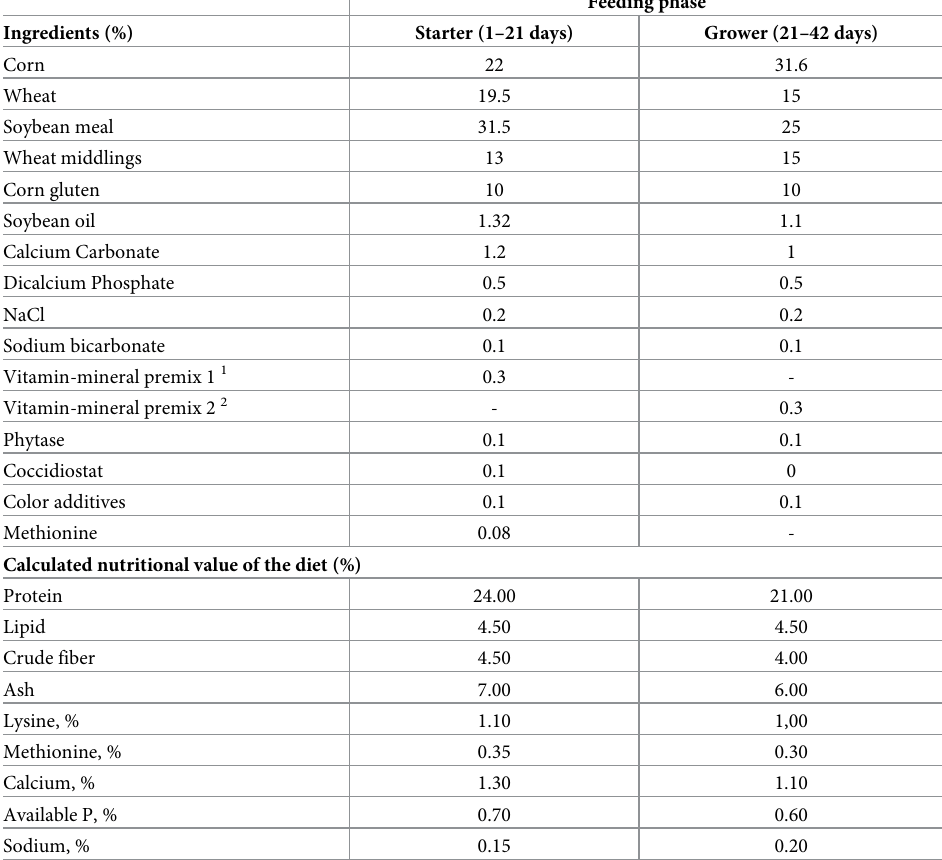
Table 1. Diet composition and nutritional value of the feed used for animal